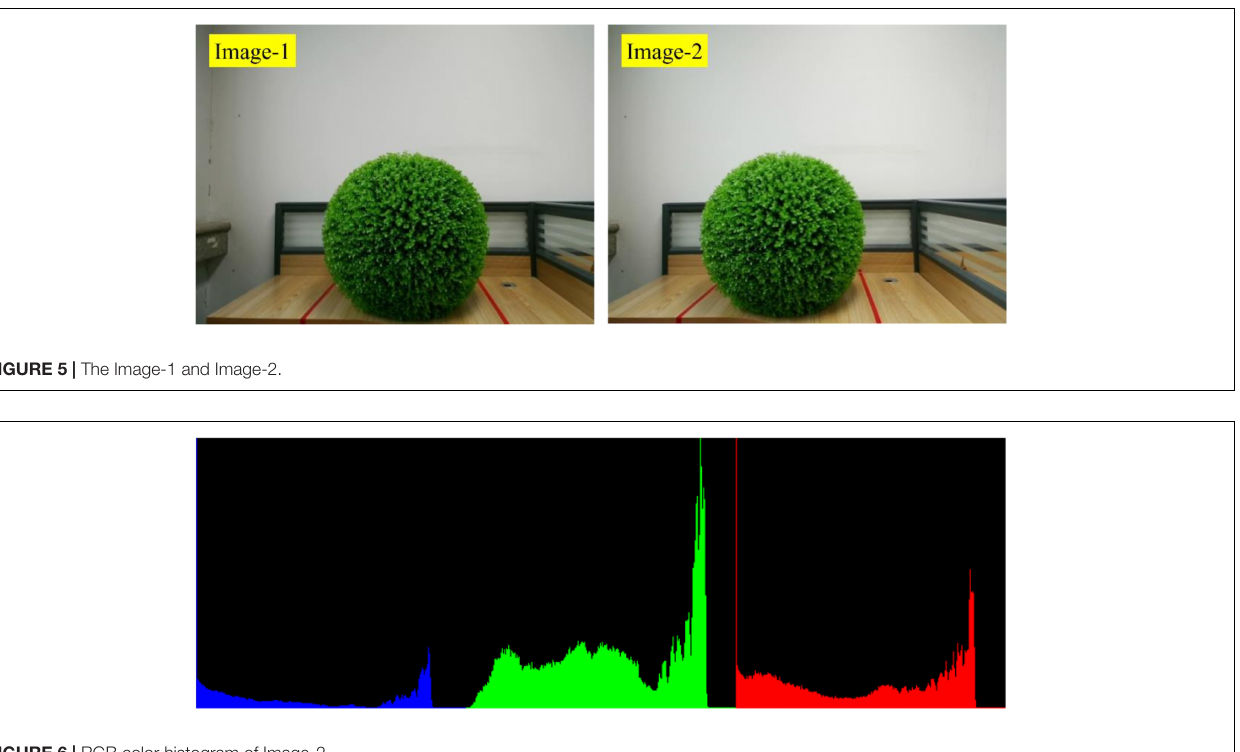
FIGURE 6 | RGB color histogram of